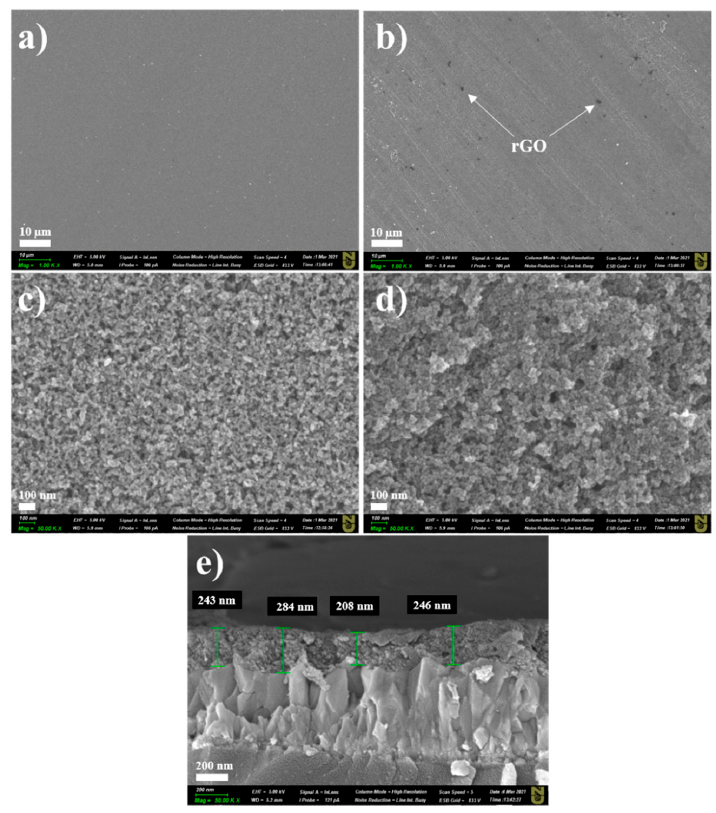
Figure 1. Low-resolution SEM images of ( a ) TiO 2 film and ( b ) TiO 2 –rGO film (scale bar—10 µm). High-resolution SEM images of ( c ) TiO 2 film and ( d ) TiO 2 –rGO film (scale bar—100 nm). Cross- sectional SEM image of ( e ) TiO 2 –rGO film (scale bar—200 nm).